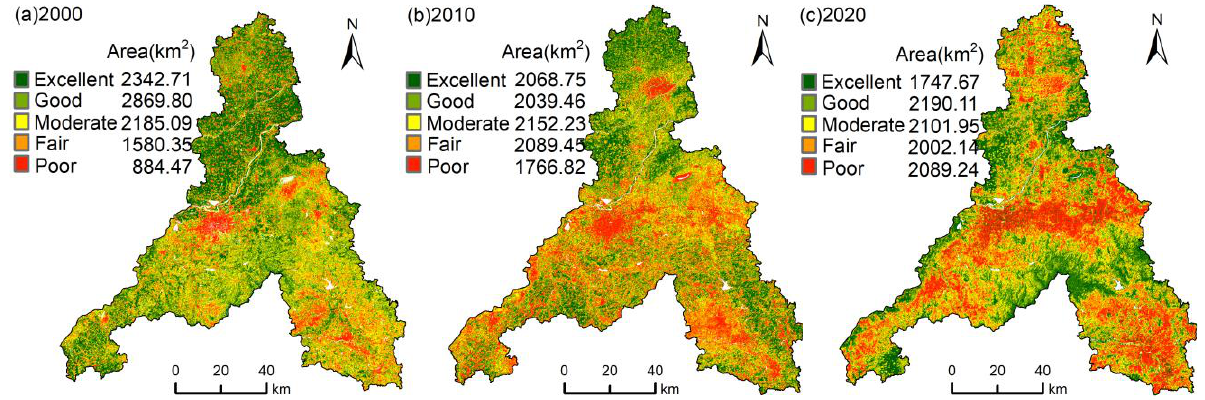
and spatial distribution of ecological quality in 2000; ( b ) is the structure